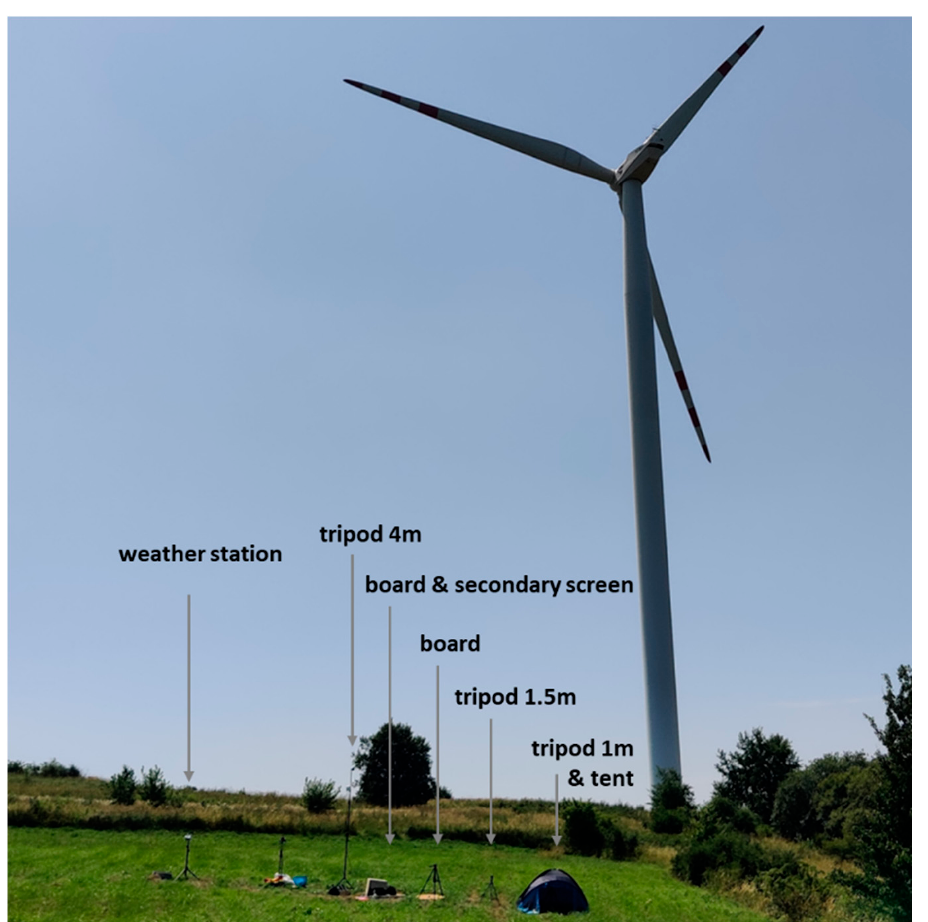
Figure 13. Placement of measuring microphones–wind farm–general view. Ten-min timeframes were chosen for the analysis due to significant gusts of wind presented in Figure 14.